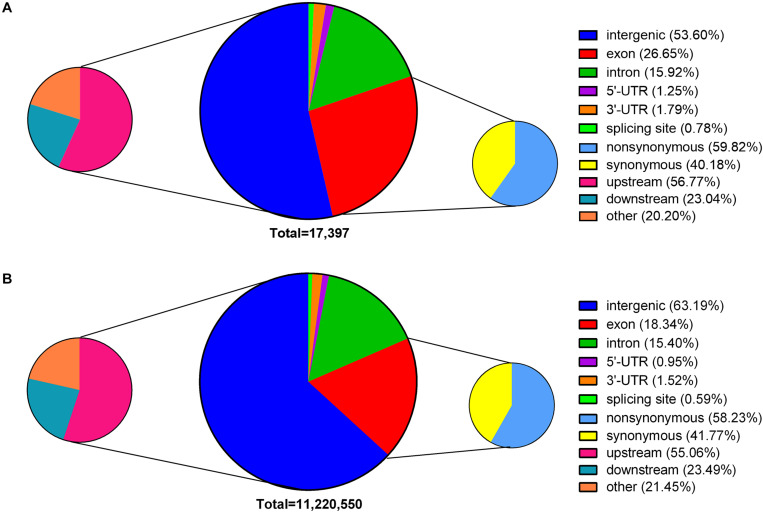
Genome-wide distribution of ethyl methanesulfonate (EMS)-induced single nucleotide polymorphic sites (SNPs) and natural SNPs. (A) EMS-induced SNPs. (B) Natural SNPs presented in the Rice3K project. SNPs within 3 kb upstream or downstream of a gene are classified as upstream and downstream. SNPs in exons are grouped into non-synonymous and synonymous according to their effects on amino acids.